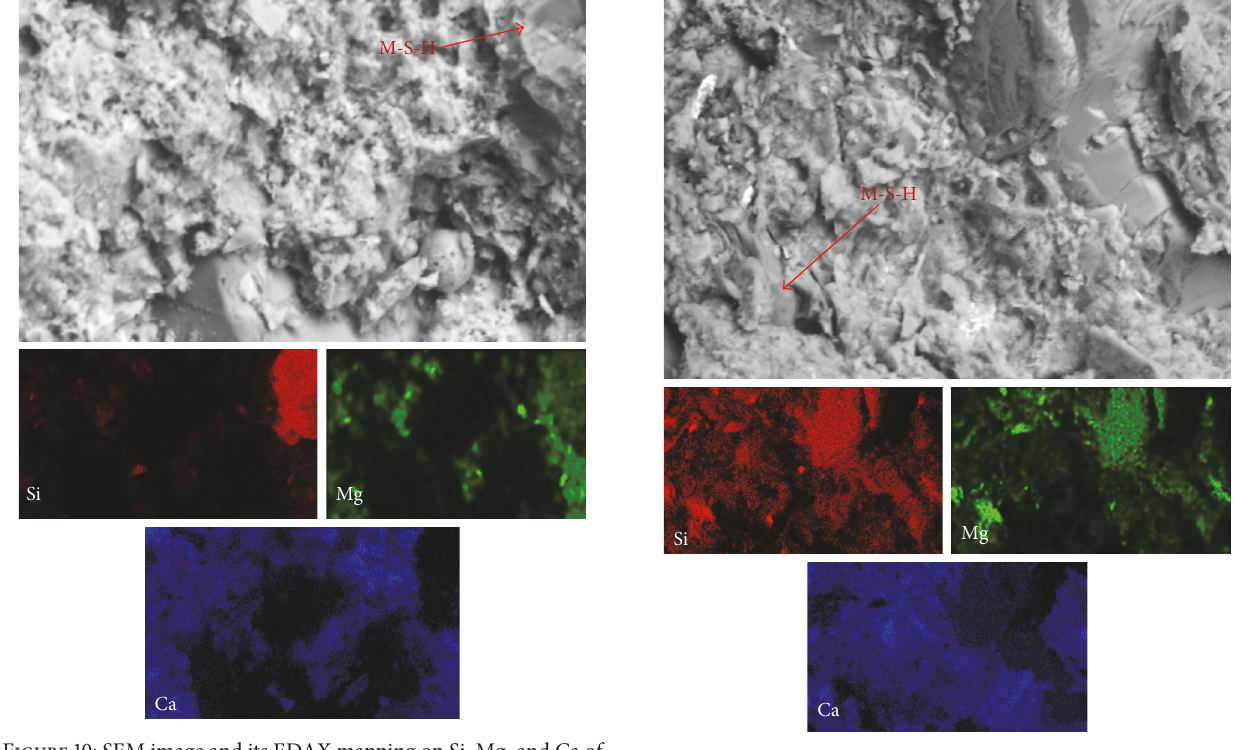
Figure 12: SEM image and its EDAX mapping on Si, Mg, and Ca of